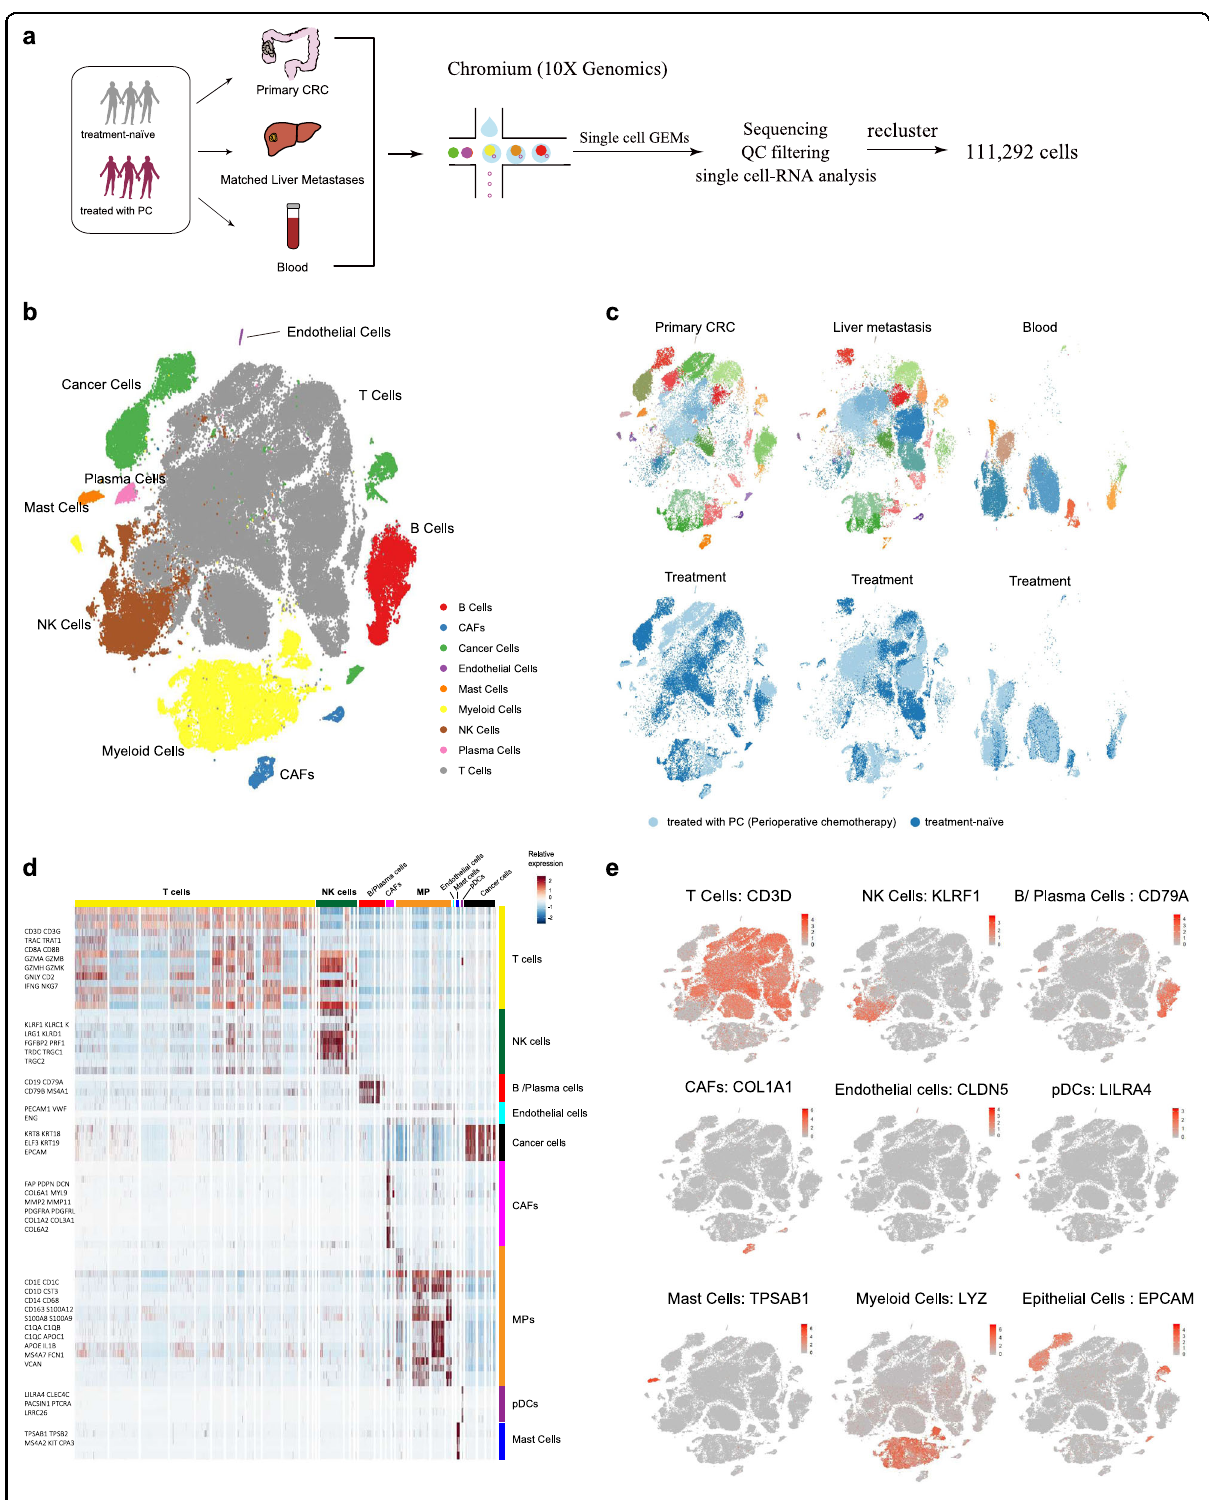
Fig. 1 Single-cell atlas of primary CRC and liver metastases. a Overview of the work fl ow for single-cell transcriptome pro fi ling of cells in primary CRC, matched liver metastases, and blood. b t-SNE plot showing the transcriptome landscape of 111,292 stromal cells from six CRC patients with liver metastasis. Colors indicate cell types. c t-SNE plot showing stromal cells colored according to tissue origins (top) and treatment status (bottom). d Heat map showing differential expression of the top expressed genes in each cluster. For each cluster, the top 10 genes and their relative expression are shown. MPs, mononuclear phagocytes; pDCs, plasmacytoid dendritic cells. e t-SNE plots showing typical markers of each major cell